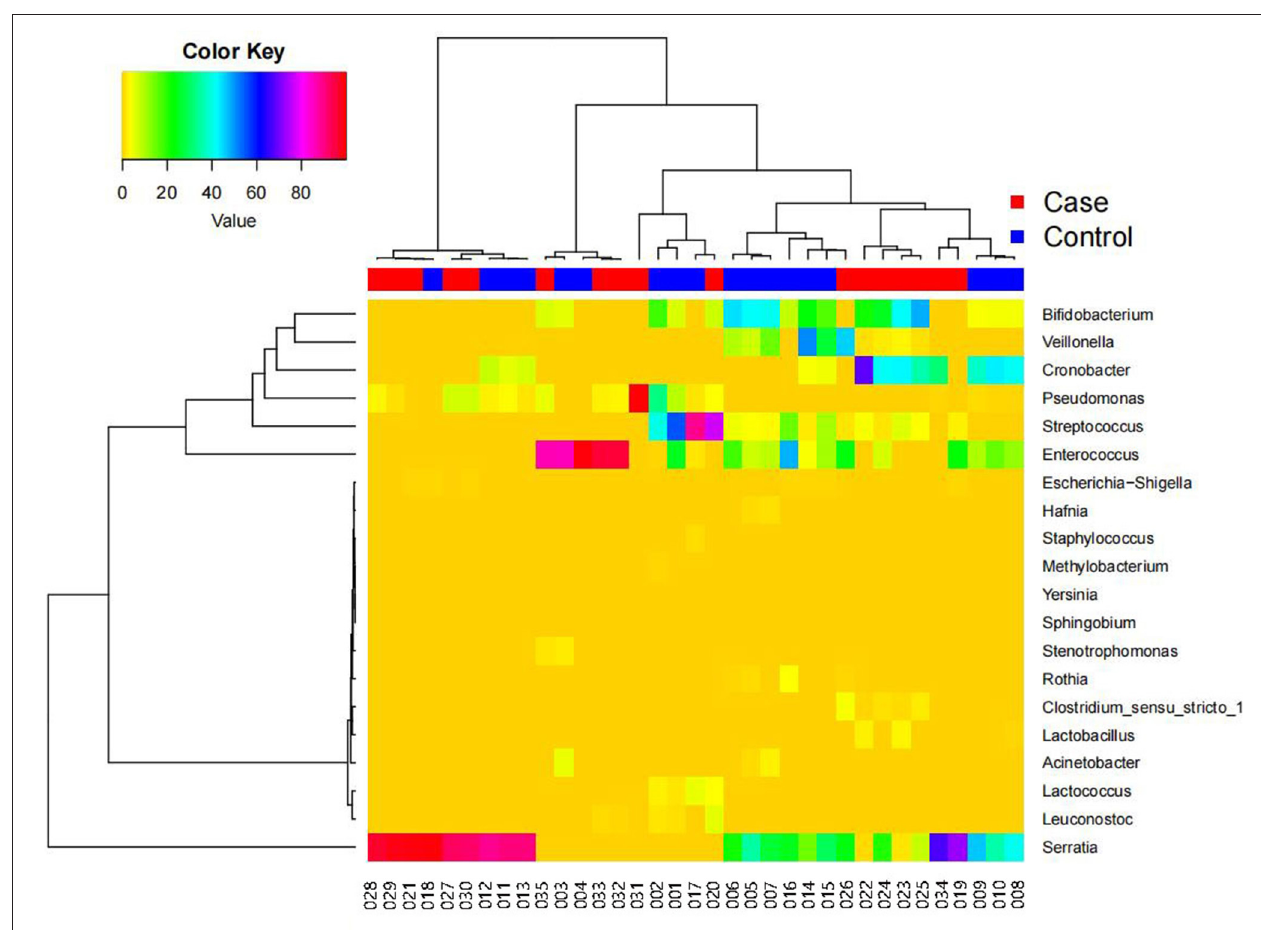
FIGURE 5 | The heat map between bacterial community in two groups at the genus level.